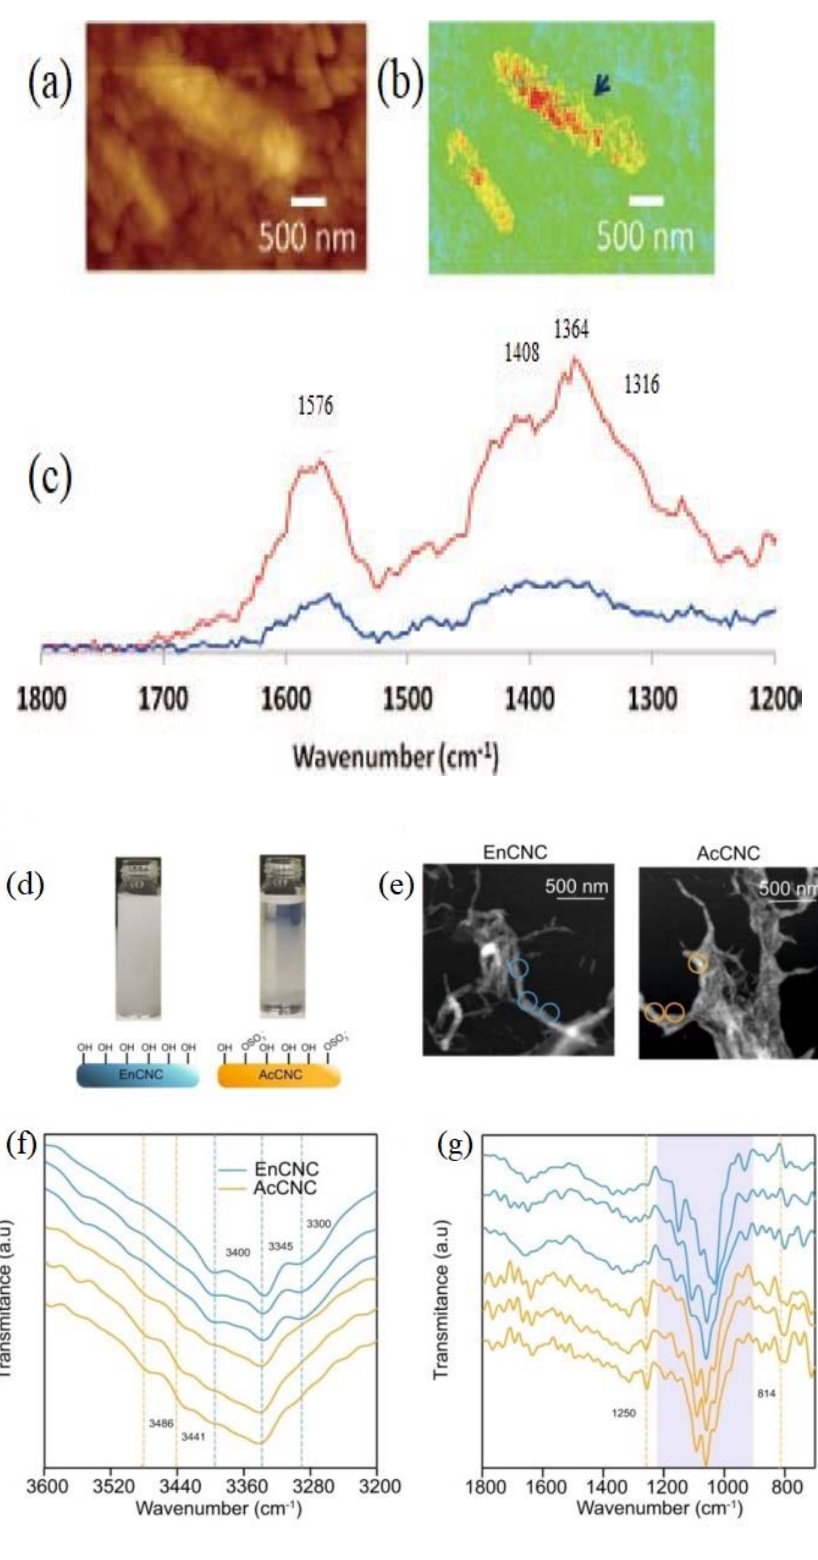
Figure 2. ( a ) AFM topography image of MFC in cellulose matrix, ( b ) NanoIR image at 1360 cm − 1 , ( c ) NanoIR spectra; ( d ) CNCs suspension produced by enzymatic and acid hydrolysis, ( e ) Topography images from EnCNC and AcCNC, ( f ) NanoIR spectra for EnCNC and AcCNC nanocrystals in 3600 to 3200 cm − 1 ( f ) and 1800 to 750 cm − 1 ( g ). Reproduced with permission from [46]. Copyright Cambridge University Press, 2012. Reproduced from [47].